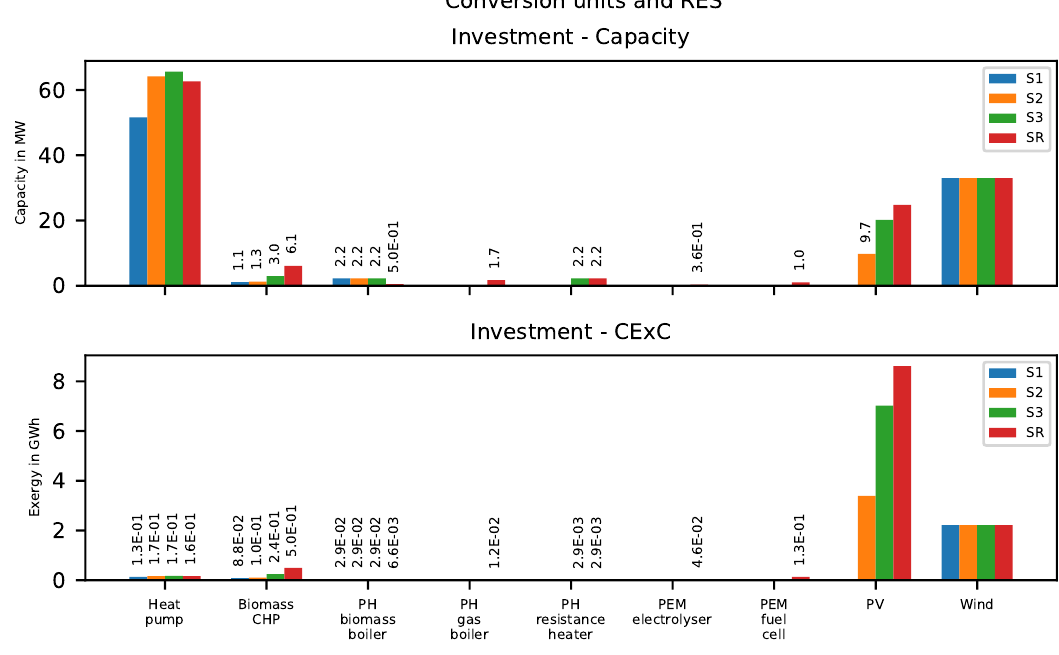
Figure 6. Calculated optimum conversion unit capacities and the corresponding CExC (Source: own